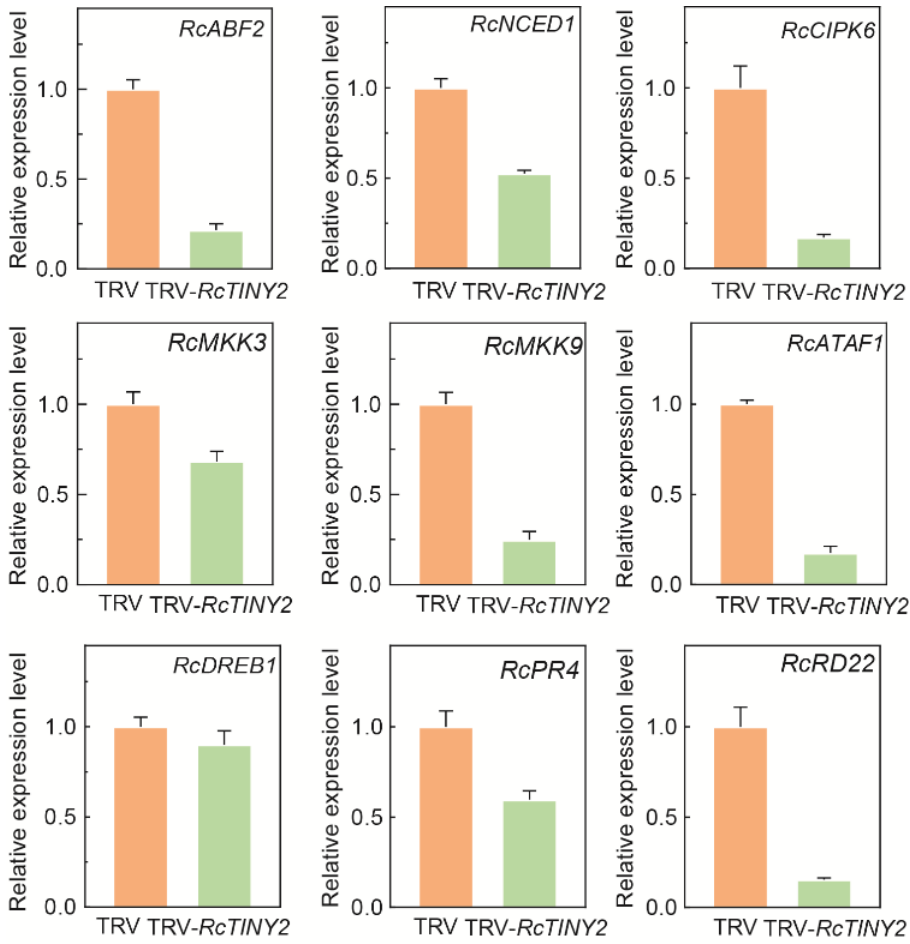
Figure 7. RT-qPCR analysis of genes in the leaves of TRV and TRV- RcTINY2 rose plants. RT-qPCR was used to investigate the transcriptional expression of nine genes ( RcABF2 , RcNCED1 , RcCIPK6 , RcMKK3 , RcMKK9 , RcATAF1 , RcDREB1 , RcPR4 and RcRD22 ) in TRV and TRV- RcTINY2 rose plants. An internal control gene, RcUBI2 , was used to normalize the relative expression of each gene of interest. All data are the mean ± SD for three independent experiments.